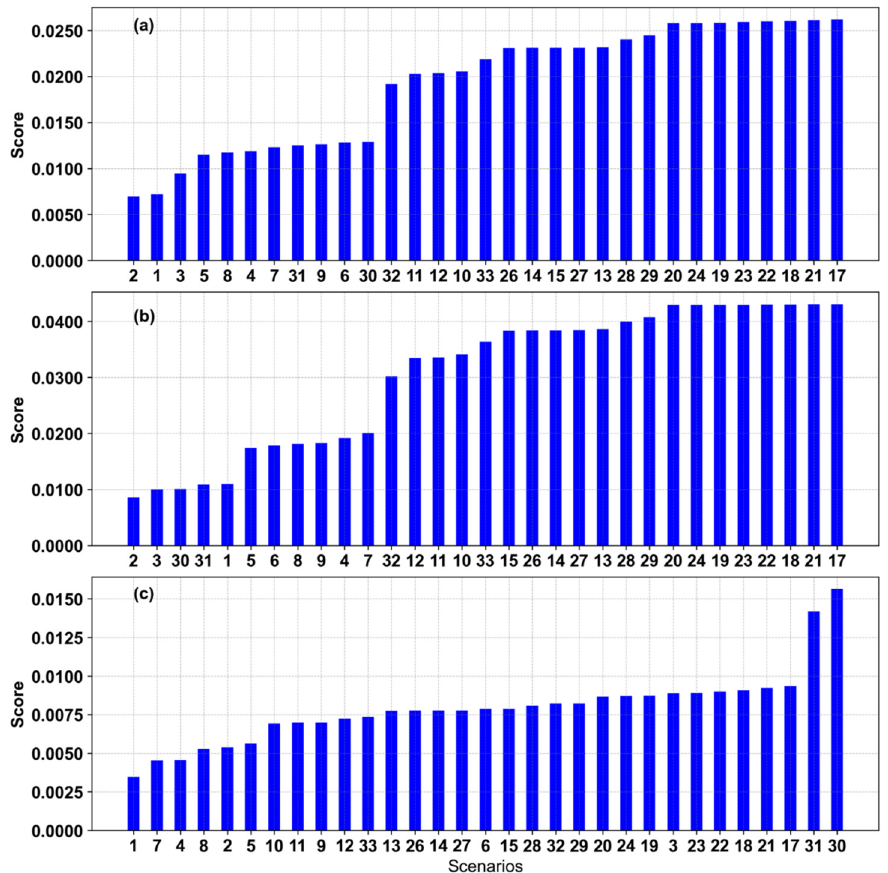
Figure 12. Scoring results comparing alternative conservation scenarios based on sediment yield per unit area and total land converted from agricultural production to a conservation practice. Three evaluations were performed: ( a ) equal weight for sediment yield and spatial footprint, ( b ) prioritize reduction in sediment yield by a factor of 5 to 1, and ( c ) prioritize reduction in spatial footprint by a factor of 5 to 1.